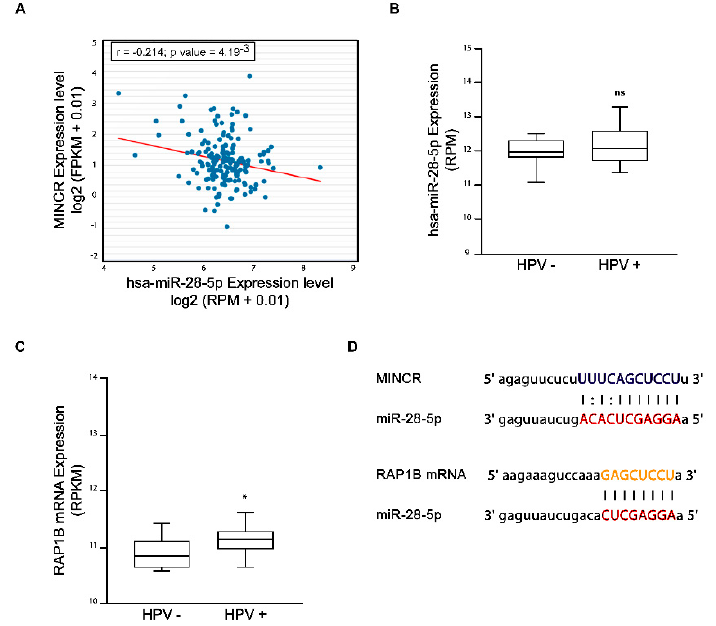
Figure 2. Bioinformatic analysis for the construction of the MINCR/miR-28-5p/RAP1B interaction axis built from data obtained from the TCGA database. ( A ) Correlation between MINCR and miR-28-5p expression levels. ( B ) Expression of miR-28-5p in patients with CC. ( C ) Expression of RAP1B mRNA in patients with DC. ( D ) Base pairing prediction for miR-28-p with MINCR and with RAP1B mRNA. The sequences were obtained using the TargetScanHuman platform; Mann–Whitney–Wilcoxon test, * p ≤ 0.05.